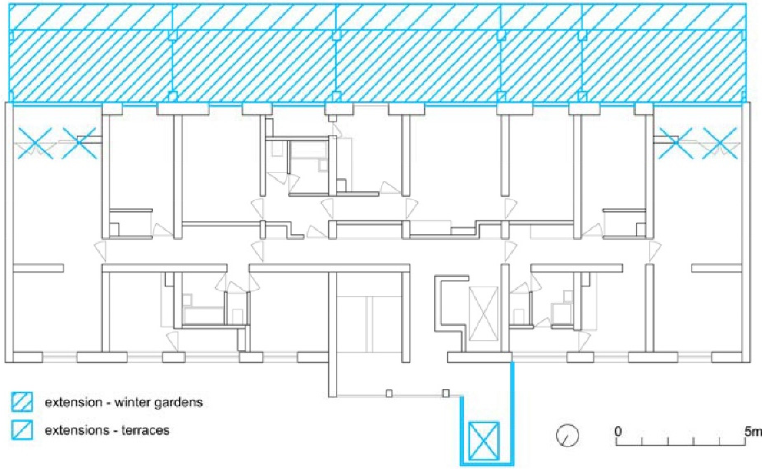
Figure 3. Transformation of the Tour Bois le Prêtre in Paris. Plan of the even level. Drawing by the author, based on [21].